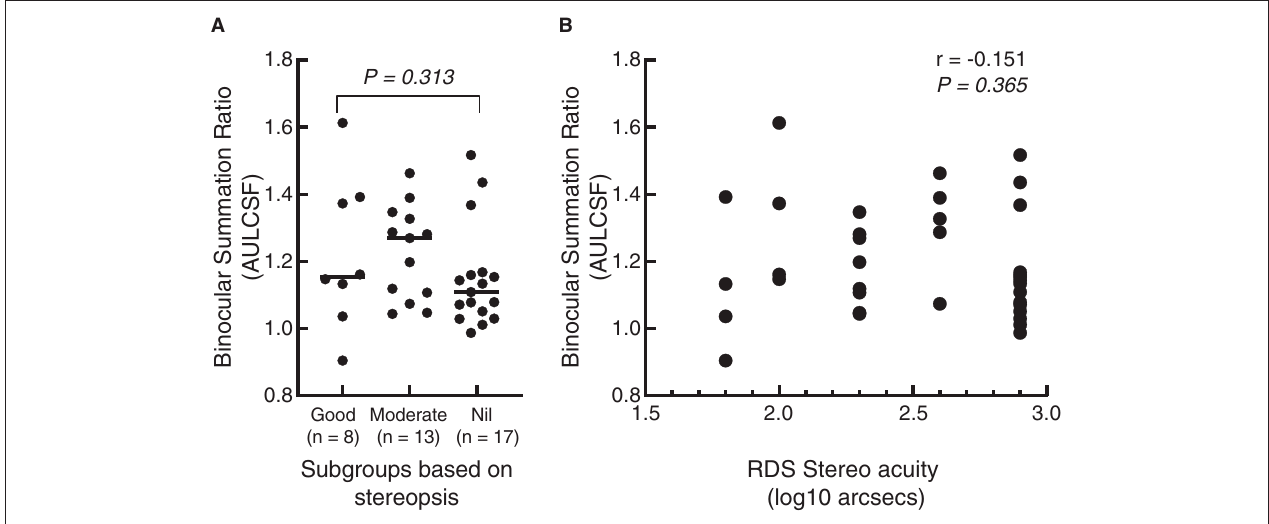
FIGURE 5 | Scattergram of correlation between binocular summation in AULCSF and stereopsis. (A) A dot plot of binocular summation ratio among different subgroups based on the results of random dot stereogram (RDS) stereopsis. The short line represents the median. (B) A dot plot of the correlation between stereopsis and binocular summation. The abscissa represents the value after log conversion of RDS stereo acuity. Each dot represents a patient. function of the non-dominant eye did not diagonally shift downward or to the left relative to that of the dominant eye and both eyes (i.e., binocular). Boxplots of BSR at each spatial frequency among them are shown in Figure 3 . A mixed repeated- measurement ANOVA revealed that the BSR was significantly different under different spatial frequencies [ F (3.693,203.099) = 2.594, P = 0.045]. In addition, there was no significant difference in BSR among the three groups [ F (2,55) = 0.416, P = 0.662] and no interaction between spatial frequency and group [ F (10,275) = 0.951, P =